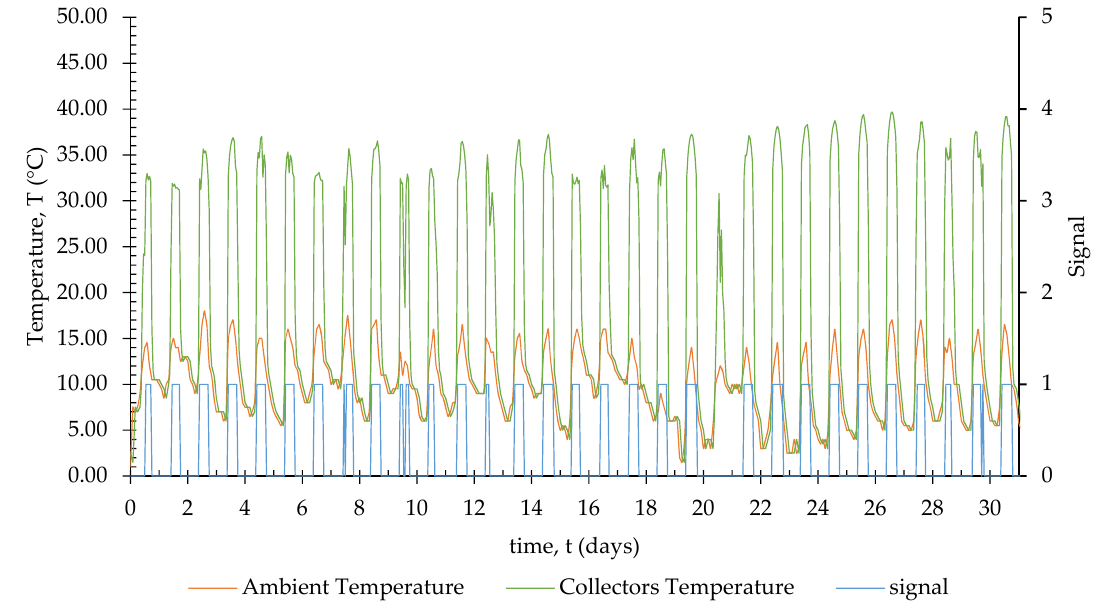
Figure 6. Solar collectors’ temperature plotted with ambient temperature and pump signal for January with 8 m 2 solar collectors.